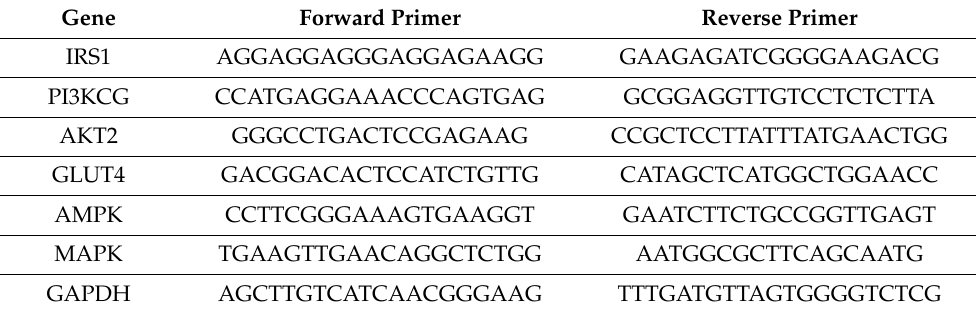
Table 1. Sequence of primers (5 (cid:48) -3 (cid:48) ) used for RT-PCR analysis. Gene Forward